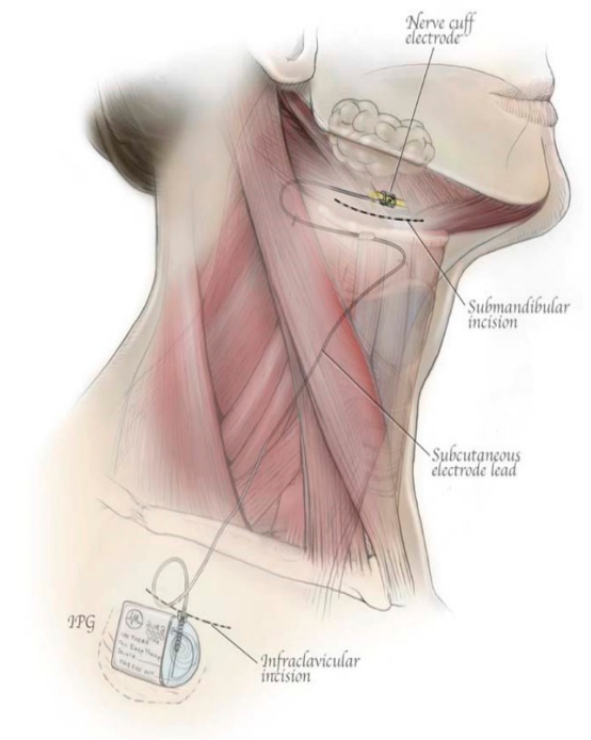
Figure 2. ImThera aura6000 (San Diego, CA, USA).